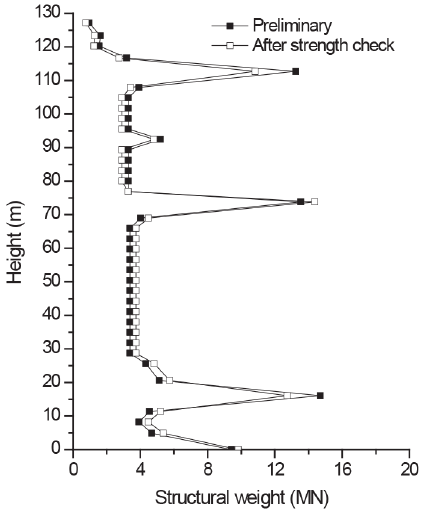
Fig. 7. Changes in the storey weights